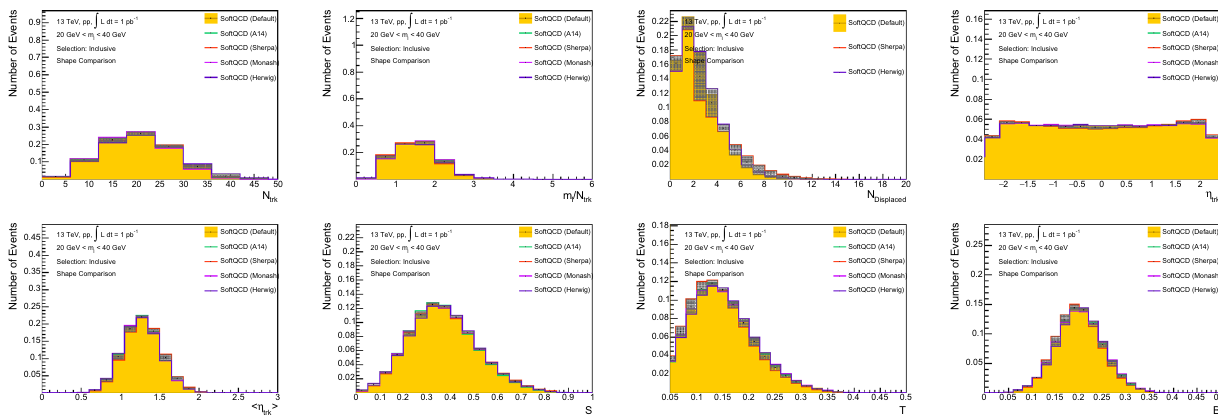
Fig. 4 Normalized distributions for softQCD processes with an invariant mass based on all tracks between 20 GeVand 40 GeV, predicted be different MC generators or generator settings: N Trk , m I / N Trk , N Displaced , η Trk , (cid:7)| η Trk |(cid:8) , S , B , T